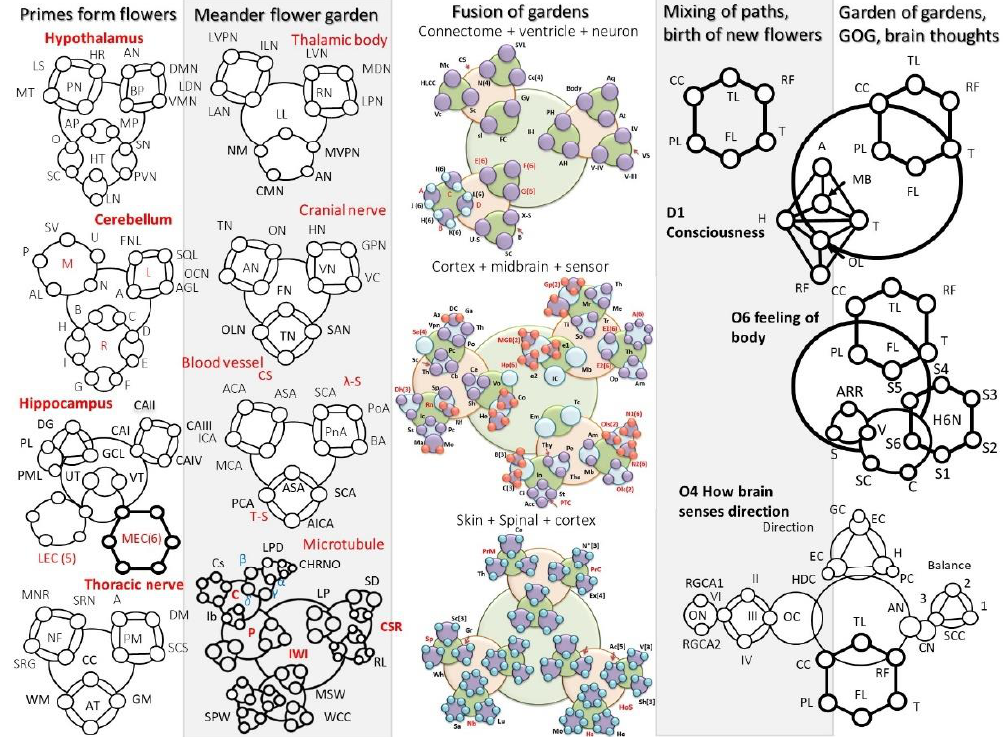
Figure 19. Five columns demonstrate how the time crystals that represent particular organ in the brain delivers a few loops and those local time crystals self-assemble to generate complex functional time crystals for conscious response of the human brain as Garden of Gardens [41] (here, column 5).